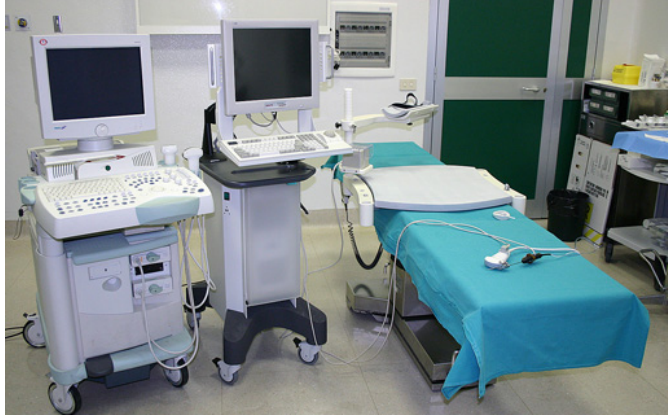
Figure 1. Image of navigator system: From left to right: Ultrasound machine, TECHNOS MPX, NAVIGATOR SYSTEM (with touch screen monitor) connected with the “navigation system”, composed by a passive electro-mechanical sensor (near to the patient) and the “active” one (attached to the ultrasound probe).